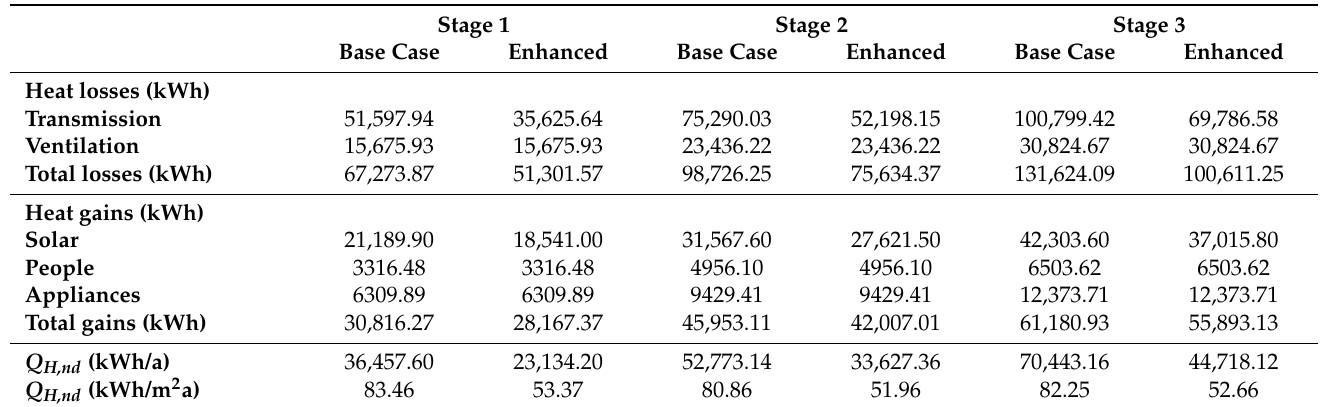
Table 8. Annual energy needed for heating.